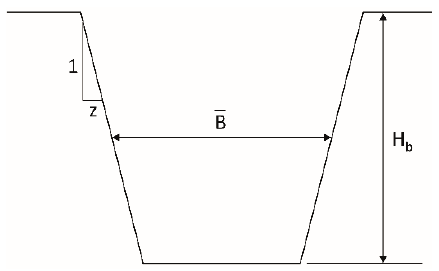
Figure 3. Trapezoidal dam breach model including height H b , average width B, and side-slope ratio z (horizontal to vertical) after Fröhlich [29].